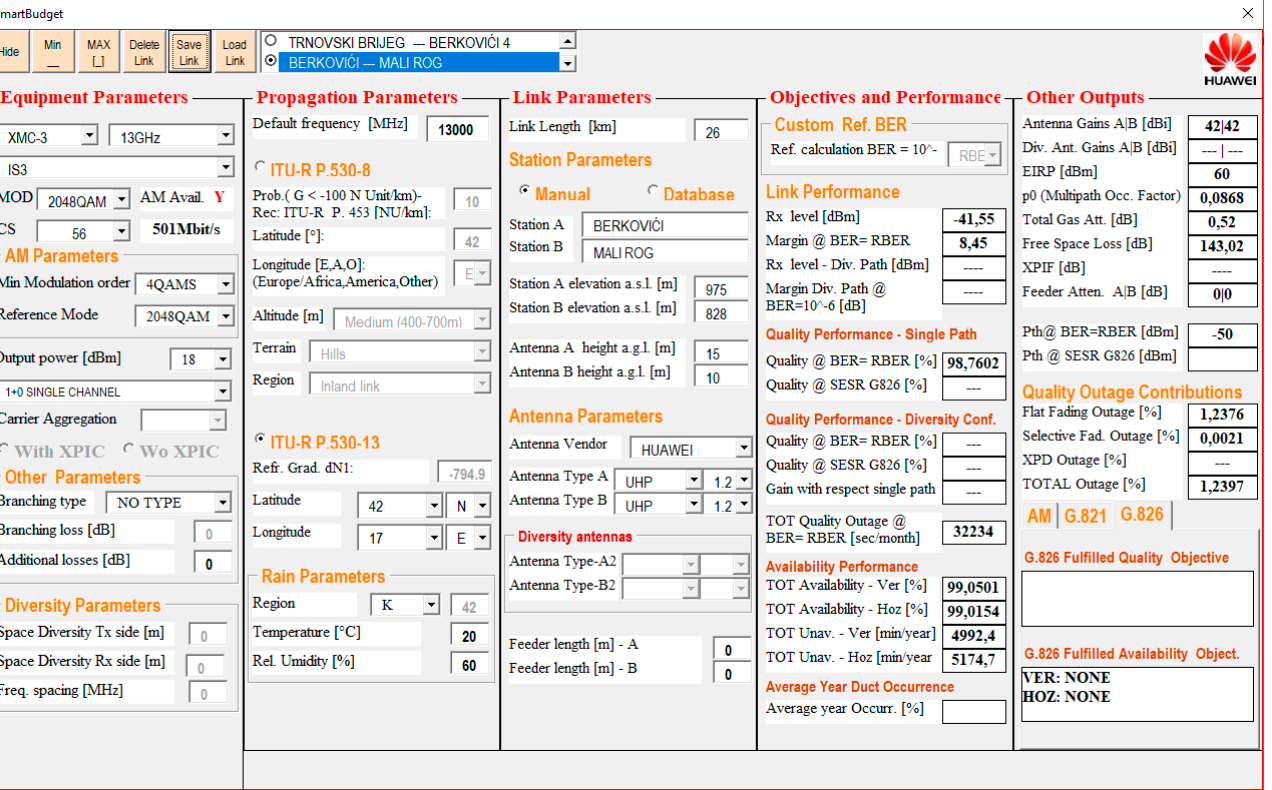
Figure 8. Prediction for the third RR section; 2048 QAM, 500 Mb/s.